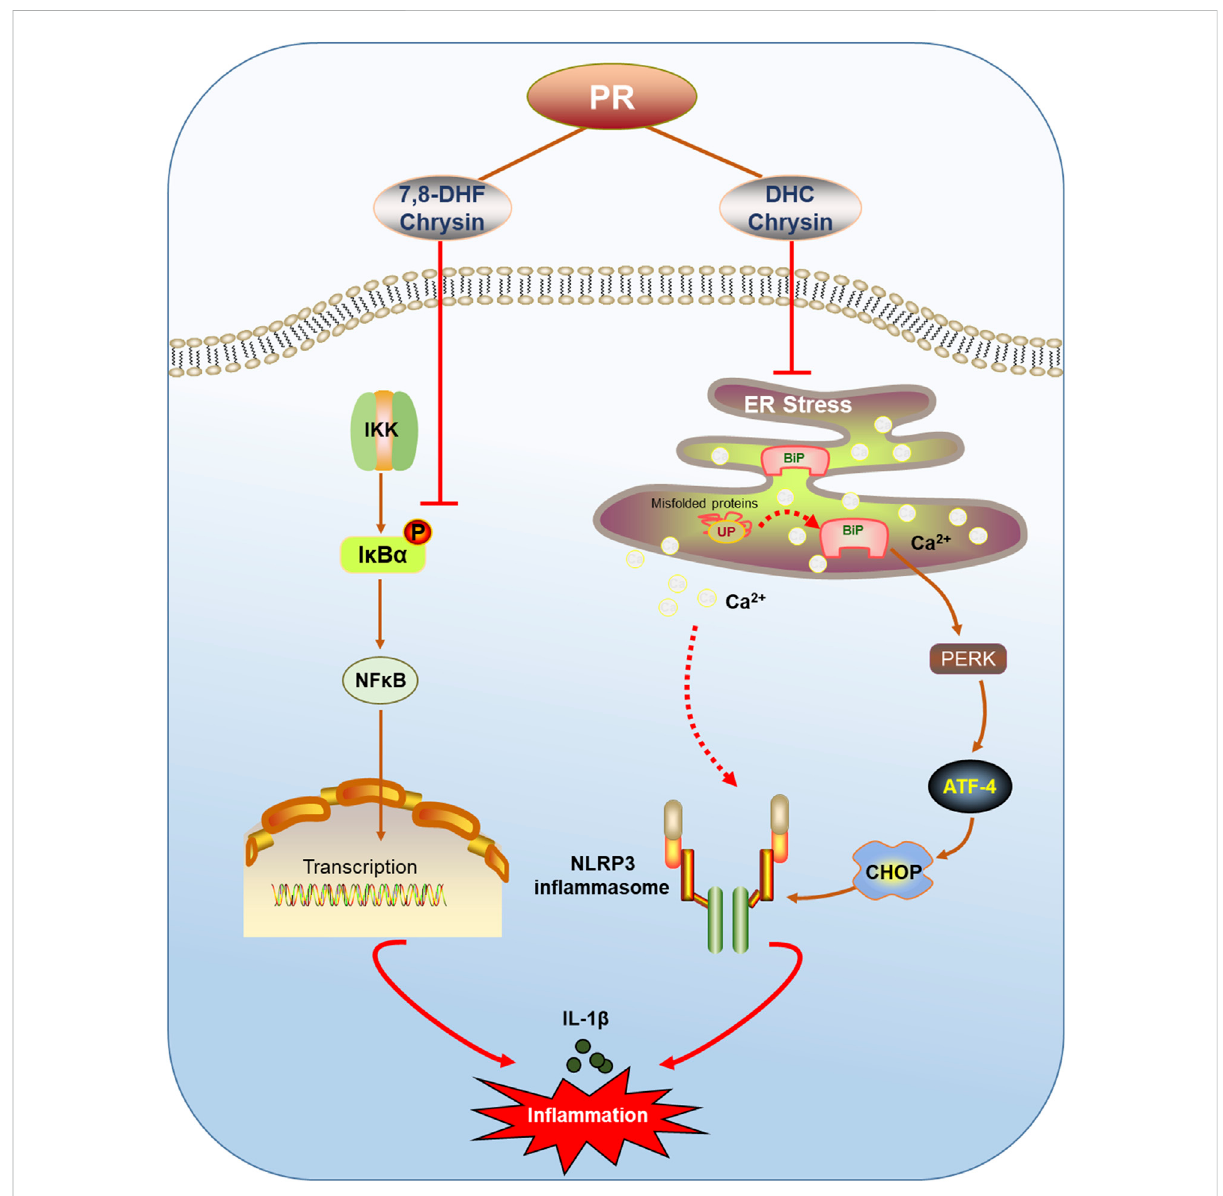
FIGURE 8 Schematic of PR relieving ALI by inhibiting ER stress. PR and its active ingredients alleviated in fl ammatory injury via regulating ER stress- mediated NLRP3 and NF- κ B signaling pathways.